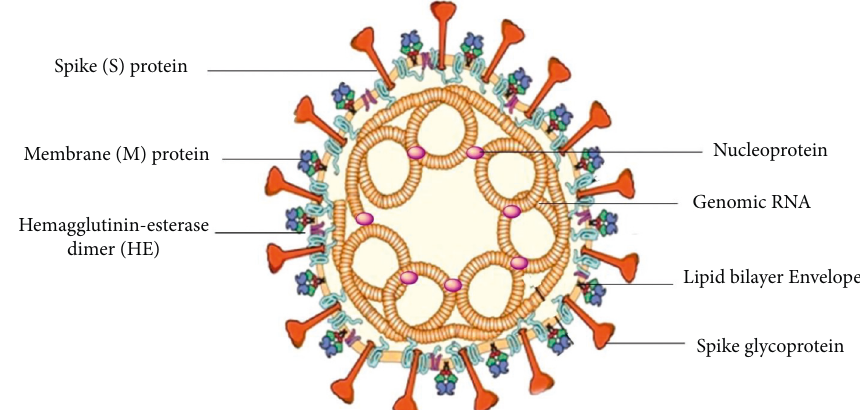
Figure 1: Schematic structure of severe acute respiratory syndrome coronavirus-2 (SARS-CoV-2), an enveloped virus with single-stranded positive-sense (+sense) RNA taking four principal proteins, including membrane (M) and spike (S) glycoproteins, in addition to nu- cleocapsid (N) and envelope (E) proteins.